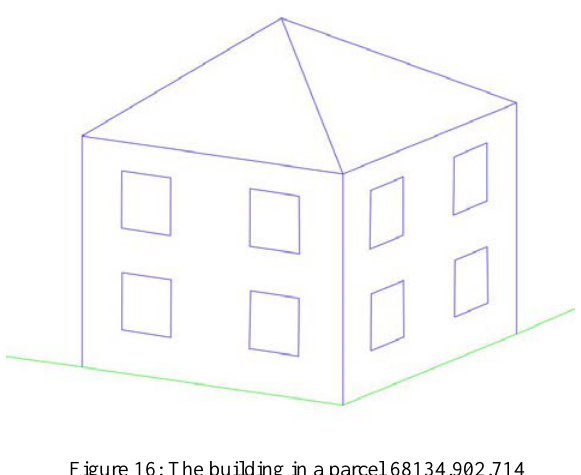
Figure 16: The building in a parcel